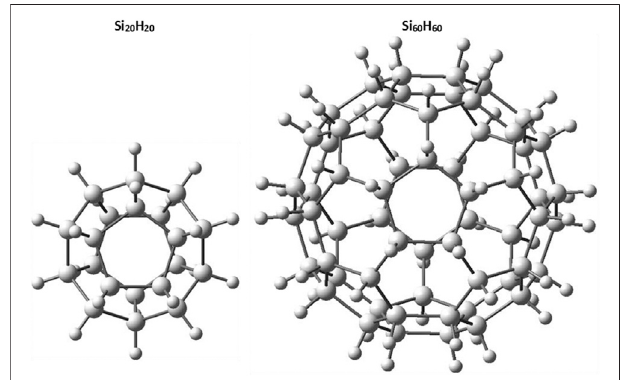
FIGURE 4 | Si 20 H 20 and Si 60 H 60 structures, which have icosahedral symmetry.